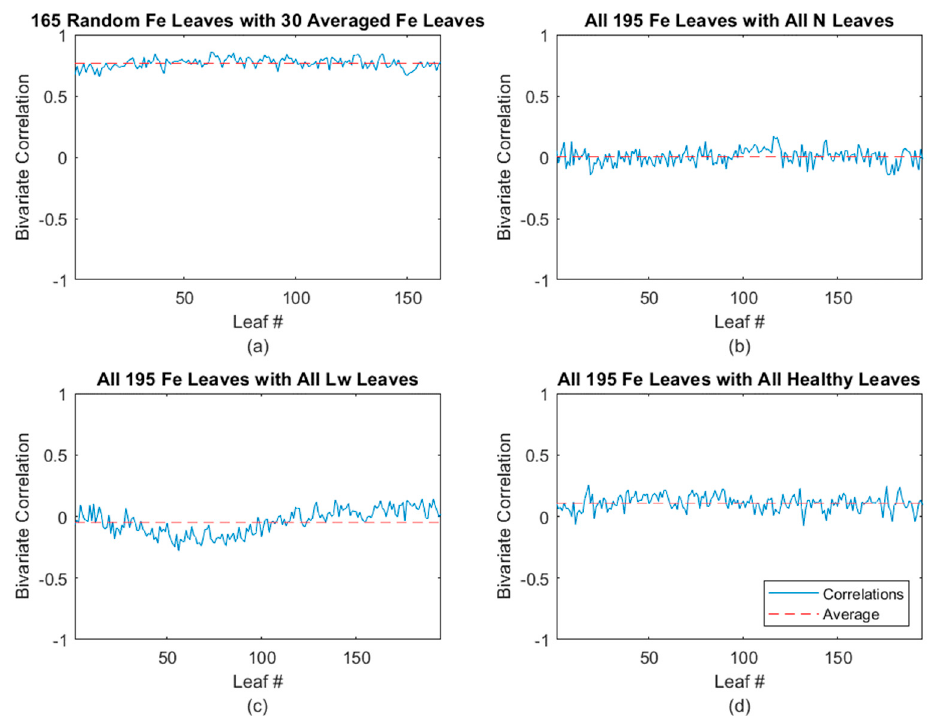
Figure 5. FDA- bivariate correlation (BC) algorithm applied for Fe-deficient avocado leaves: Figure 5. FDA ‐ bivariate correlation (BC) algorithm applied for Fe ‐ deficient avocado leaves: ( a ) Fe ‐ ( a ) Fe-deficient correlated with Fe-deficient; ( b ) Fe-deficient correlated with N-deficient; ( c ) Fe-deficient deficient correlated with Fe ‐ deficient; ( b ) Fe ‐ deficient correlated with N ‐ deficient; ( c ) Fe ‐ deficient correlated with Lw; and ( d ) Fe-deficient correlated with healthy. correlated with Lw; and ( d ) Fe ‐ deficient correlated with healthy.